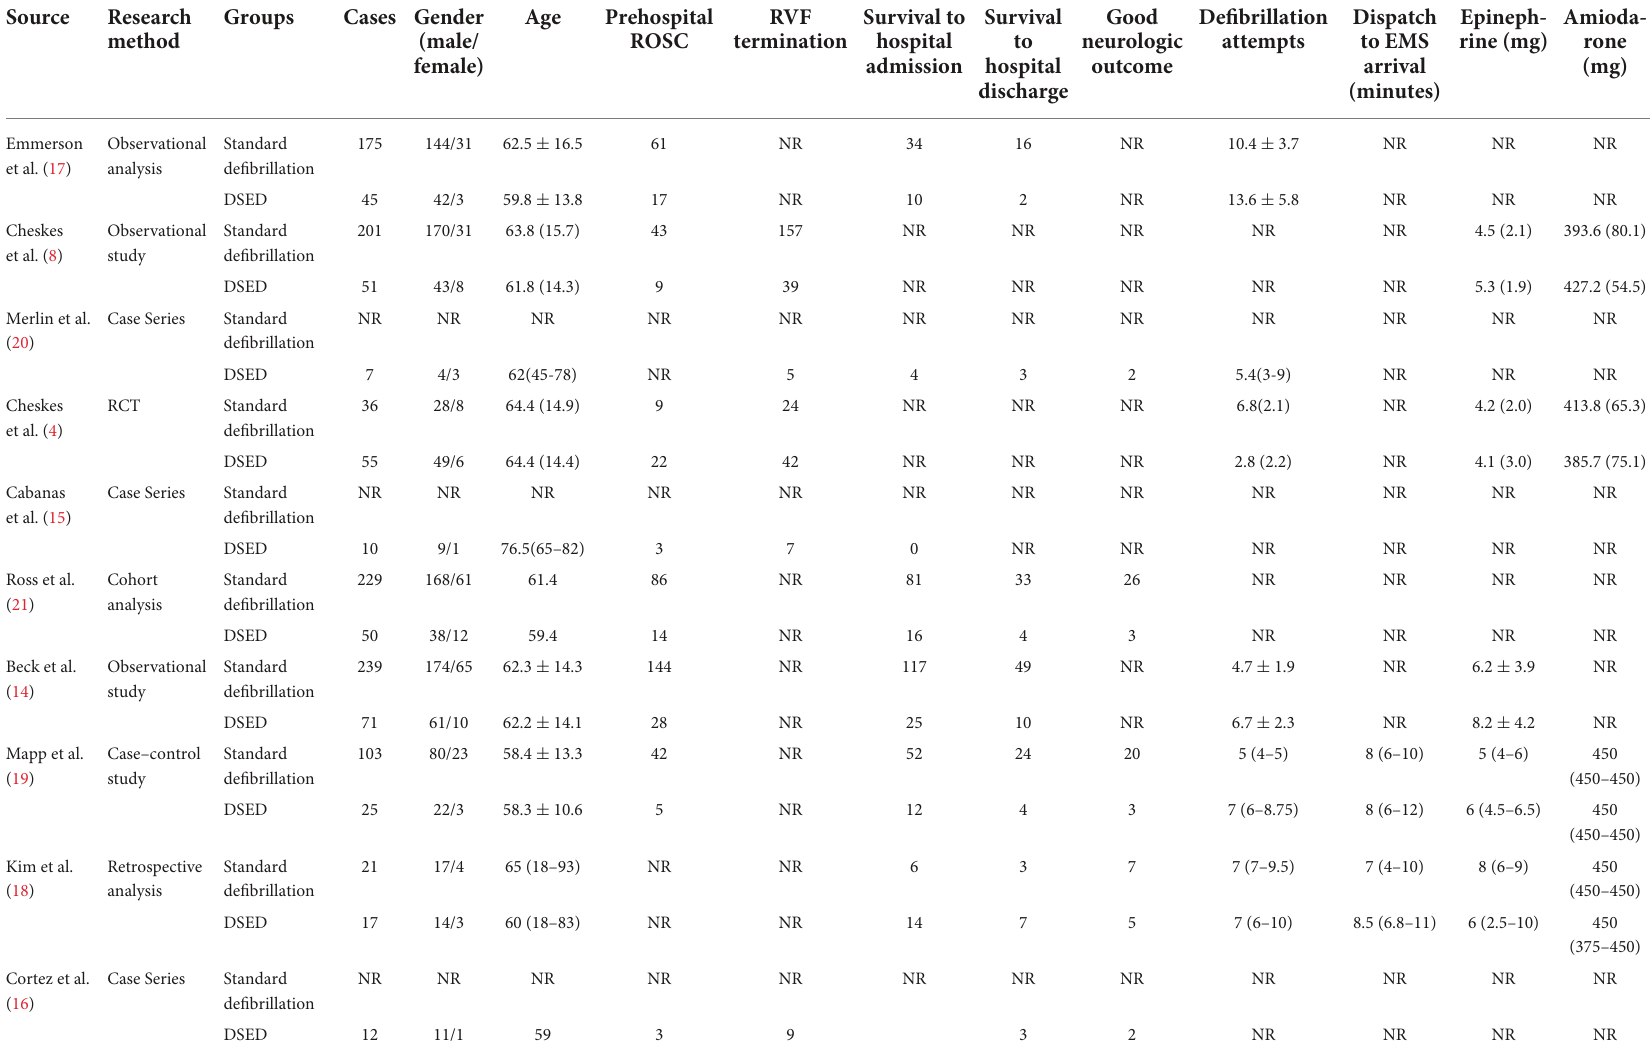
TABLE 1 Characteristics of studies included in the